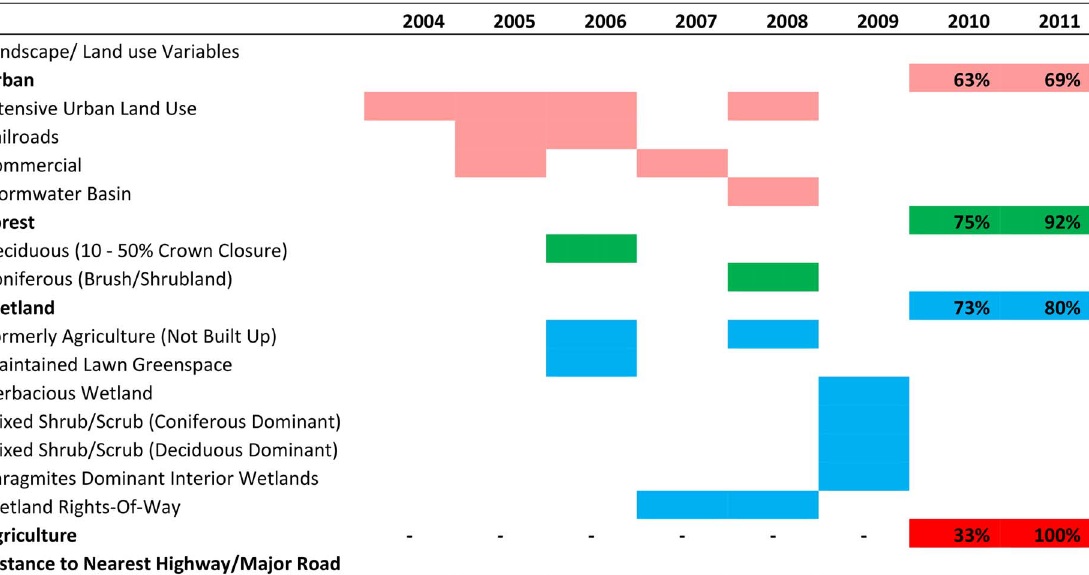
Figure 4. Summary table of landscape/land use variables that displayed significant positive relationship with densities of Halyomorphahalys using Bayesian linear regression analysis. Pink represents urban landscape/land use variables; green represents forest landscape/land use variables; blue represents wetland landscape/land use variables; and red represents agricultural landscape/land use variables. In 2010 and 2011 we calculated the total number of these relationships observed.